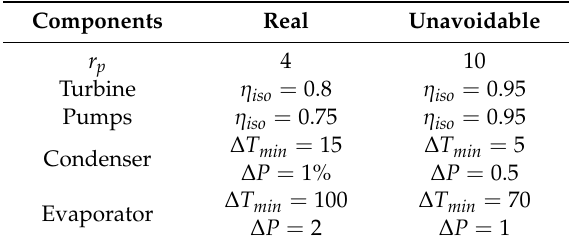
Table 10. Unavoidable operation condition for each component [8,42].